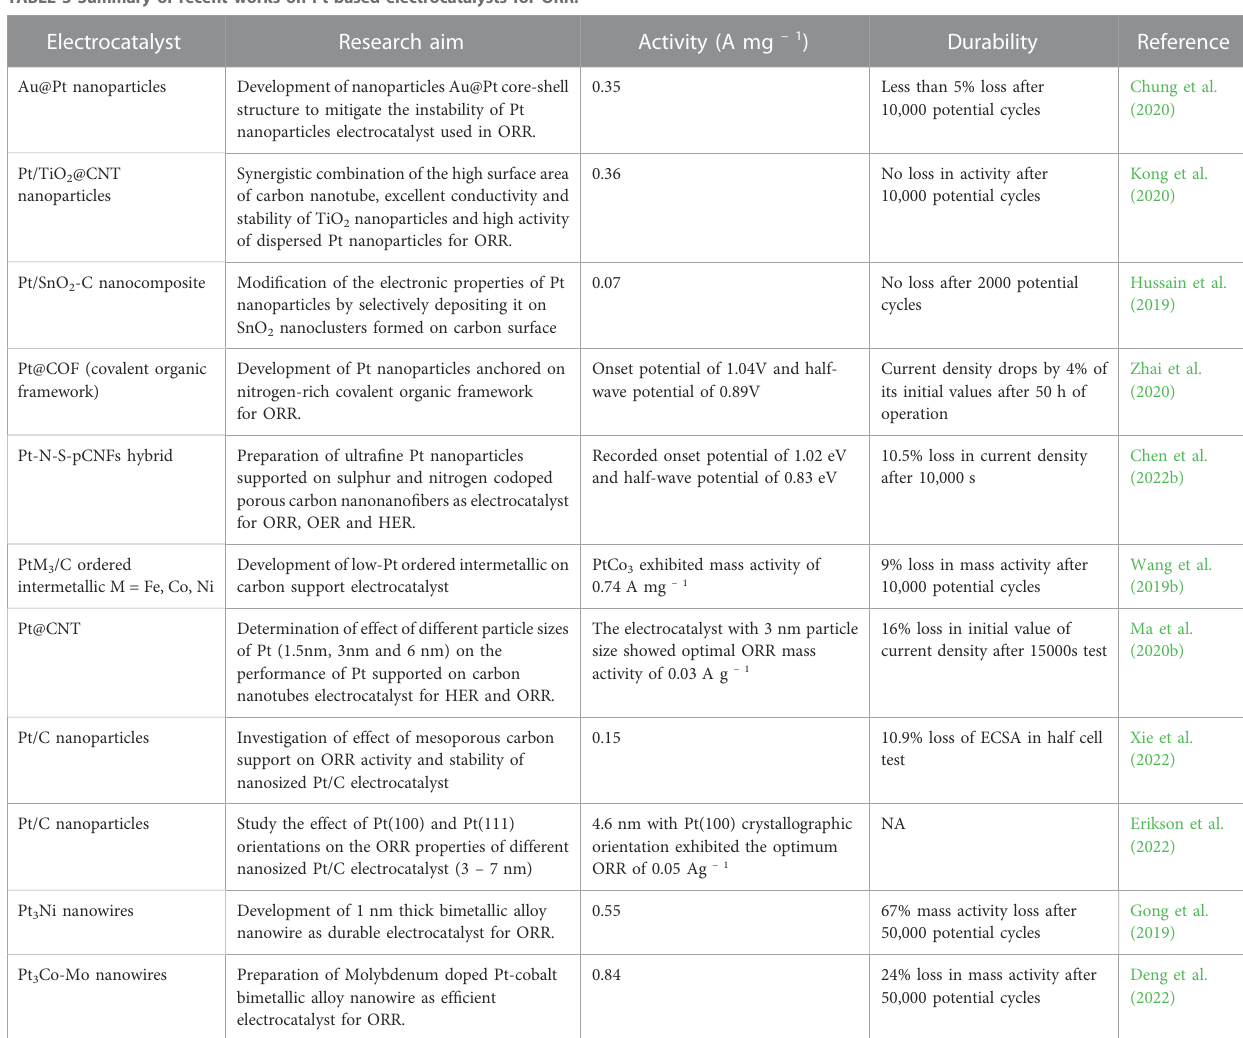
TABLE 3 Summary of recent works on Pt-based electrocatalysts for